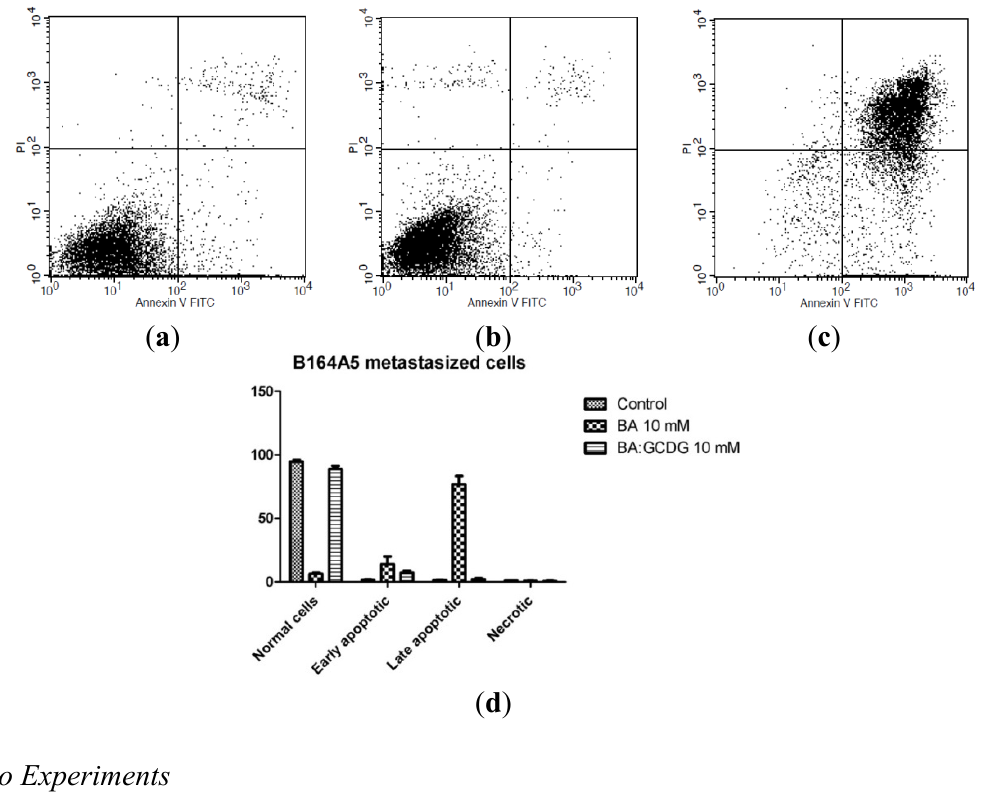
Figure 7. Representative dot-plots for Annexin V-FITC-PI-double staining after a period of incubation of 72 h for metastatic B164A5 cells: ( a ) Control; ( b ) BA 10 mM; ( c ) BA:GCDG 10 mM; and ( d ) quantification as percent viable cells during apoptosis (early and late apoptosis) and necrosis, using FACS software of the metastatic B164A5 cells: control, treated with BA dissolved in DMSO and BA:GCDG complex. Data are the mean ± SE of at least three independent